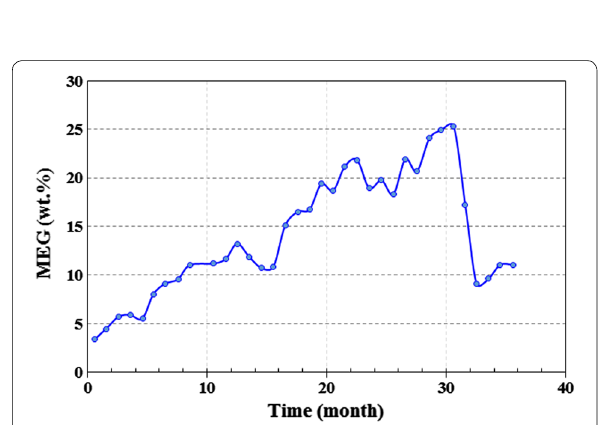
Fig. 9 MEG content throughout the 36 months in amine gas sweetening loop